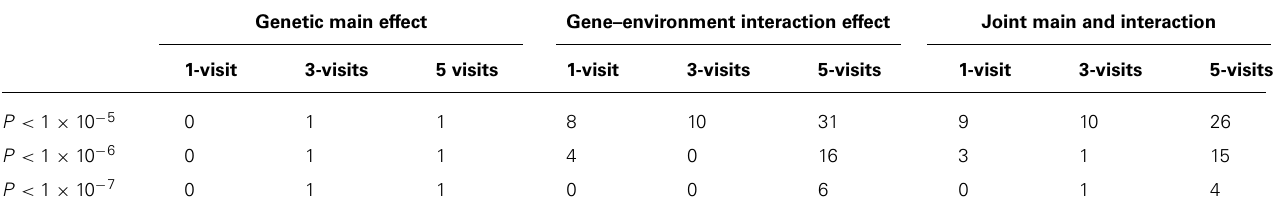
Table 3 | Number of SNPs with P -values below thresholds.